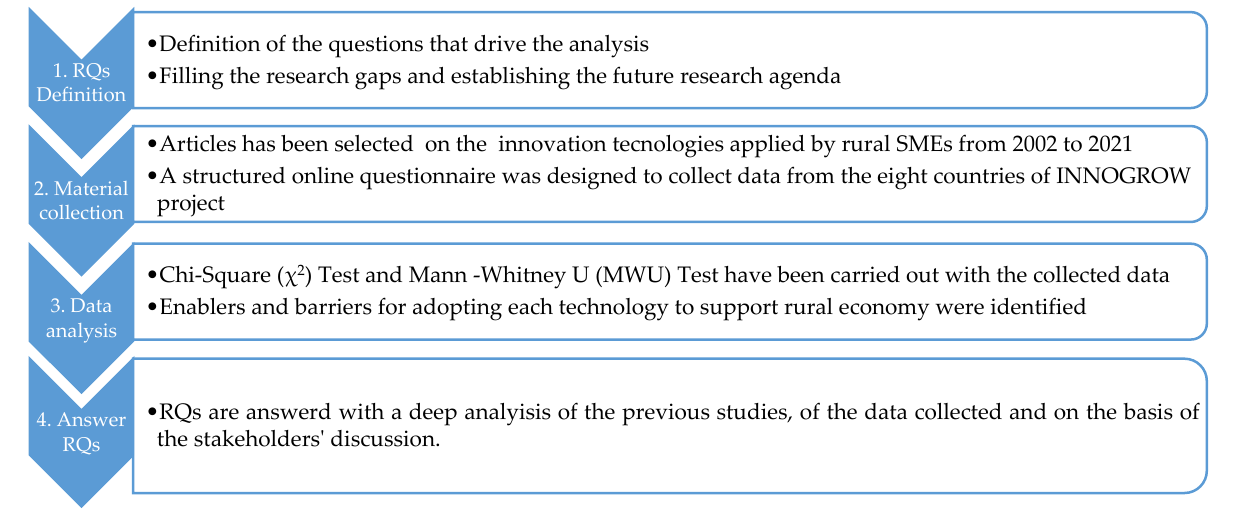
Figure 1. Research